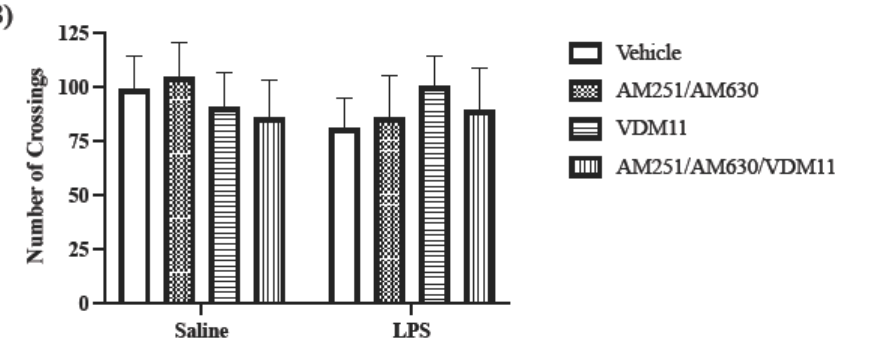
Figure 6. ( A ) Mice given various doses of VDM11, an anandamide reuptake inhibitor, 24 h after LPS injection did not significantly modify the number of crossings in the open field test (OFT). ( B ) Mice treated with a combination of 1 mg/kg each of the CB1 receptor antagonist AM251 and the CB2 receptor antagonist AM630, along with 10 mg/kg each of the anandamide reuptake inhibitor VDM11 24 h after LPS administration, did not experience a significant change in the number of crossings in the open field test (OFT).